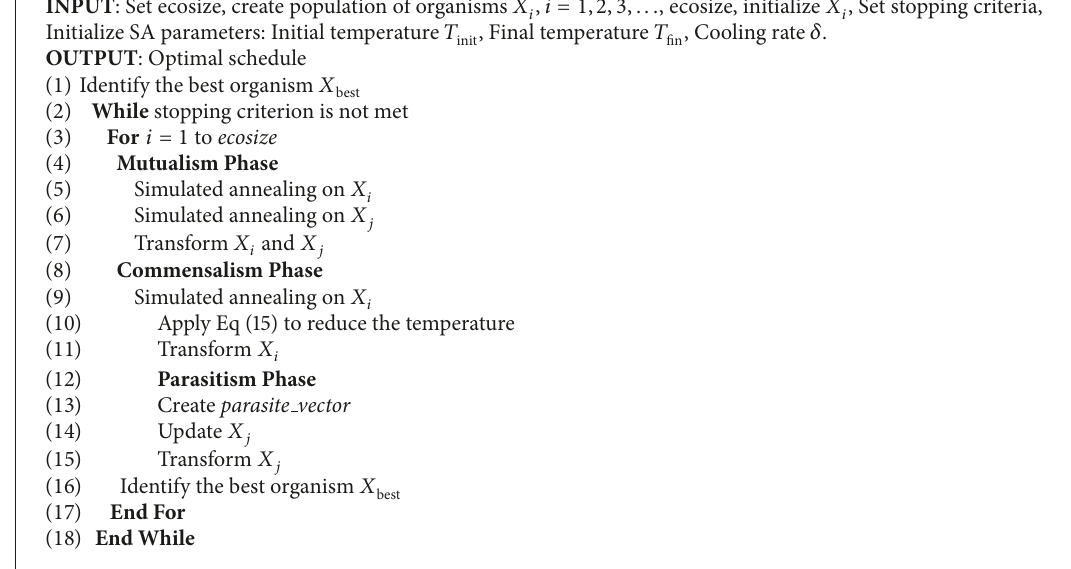
Algorithm 1: The pseudo code for SASOS